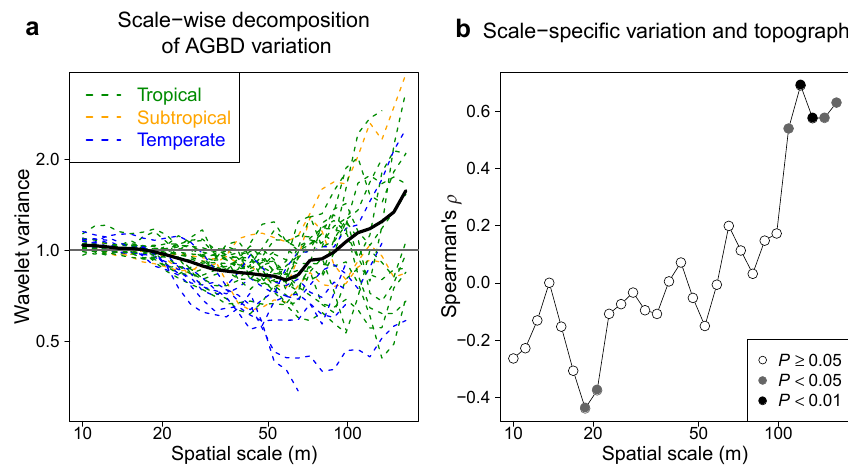
Figure 5. Scale-wise decomposition of spatial variation in AGBD and its relationship to elevation range. (a) The normalized wavelet variance of AGBD as a function of spatial scale for individual plots (coloured lines) and for the ensemble average across plots (solid black line). A wavelet variance at a given scale reflects the spatial structure of AGBD specific to that scale, with a value of 1 (solid grey line) indicating no spatial autocorrelation, lower values indicating negative spatial autocorrelation, and higher values positive spatial autocorrelation. Separate graphs for each site, with confidence intervals for the null hypothesis of no spatial correlation, are shown in Fig. S9. (b) Among-site Spear- man’s ρ correlation of the elevation range with the wavelet variance for different spatial scales. P values of Spearman’s ρ correlation tests are provided within the